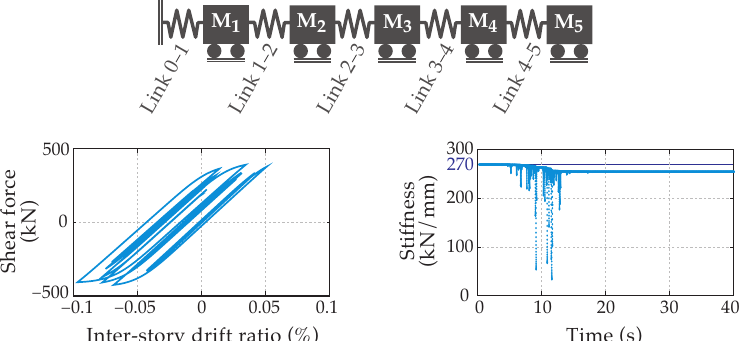
Figure 3. Schematic representation of the spring-mass model ( top ) and behavior of link 0-1 for an example earthquake ( bottom ).